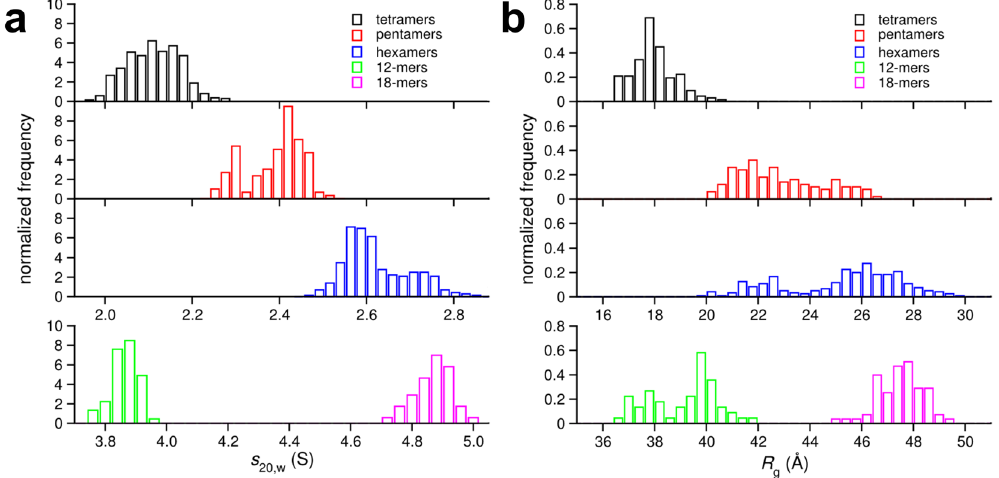
Figure 5. Calculated sedimentation coefficients and radii of gyration of A β 42 oligomers obtained from MD simulations. ( a ) Normalized distributions of sedimentation coefficients for A β 42 tetramers (black), pentamers (red), hexamers (blue), 12-mers (green), and 18-mers (magenta). ( b ) Normalized radii of gyration for the ensembles of A β 42 tetramers (black), pentamers (red), hexamers (blue), 12-mers (green), and 18-mers (magenta). All values for tetra- to hexameric A β 42 oligomers were calculated with the program HydroPro._ ENREF_69 Corresponding weight averaged s -values are summarized in Table 2.